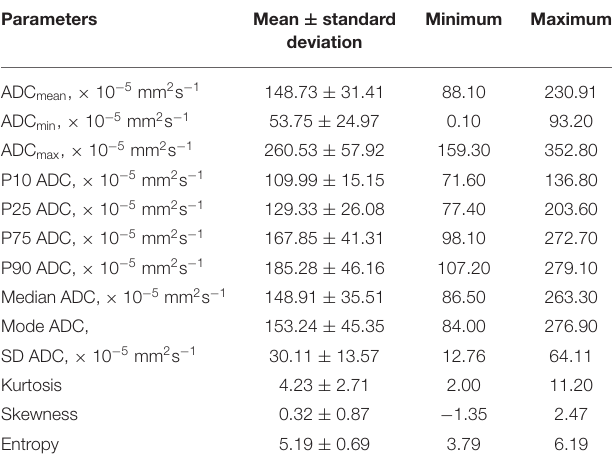
TABLE 1 | DWI histogram profiling parameters of all investigated low-grade gliomas.